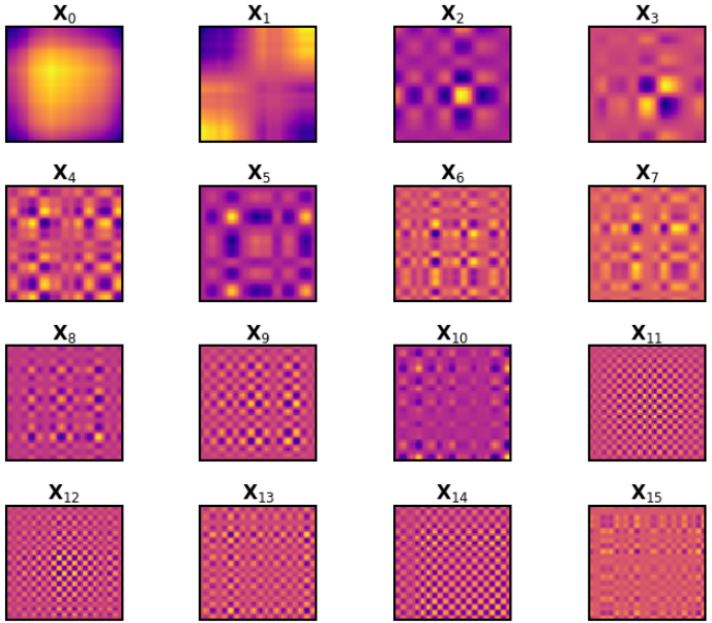
Figure 9. First 15 elementary matrix graphs out of 332